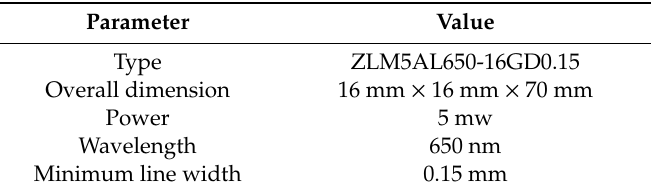
Table 3. The main specifications of the camera.